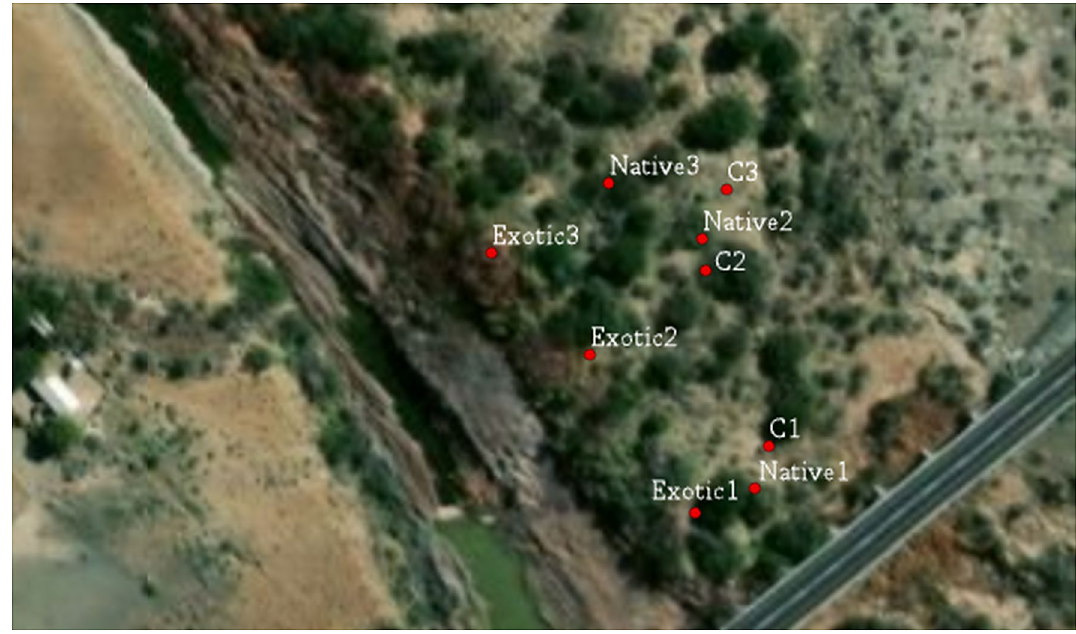
Figure 1. Soil sampling points along transect in Leeu River in the Western Cape Province. Exotic (1, 2 and 3) is exotic Tamarix species, native (1, 2 and 3) is native Tamarix species and C (1, 2 and 3) is control ( Tamarix free